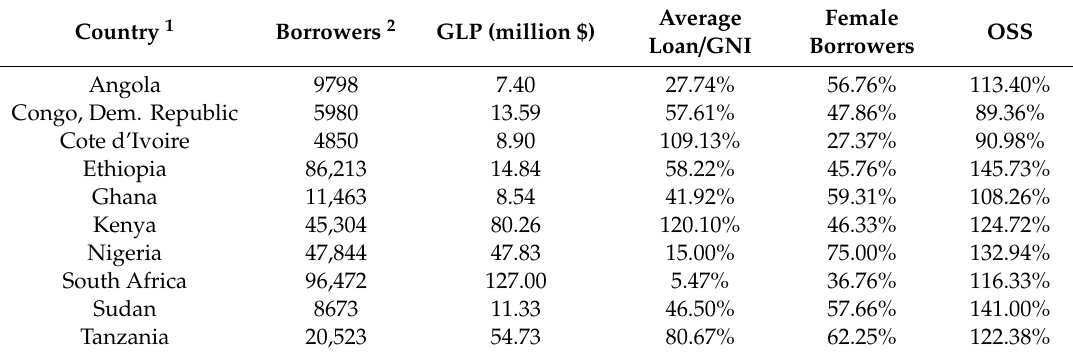
Table A3. Performance of MFIs in the 10 biggest economies of Sub-Saharan Africa